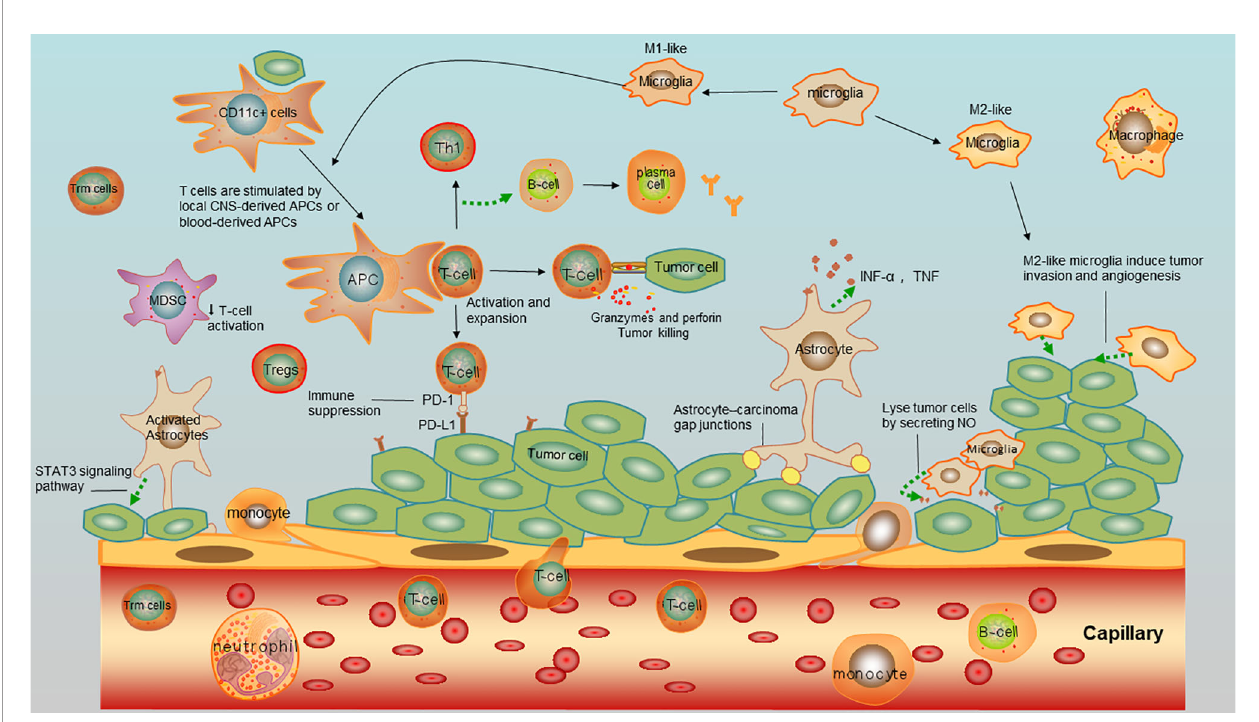
FIGURE 3 | Immnue microenvirment of brain metastases of NSCLC. Tumor cells interact with tumor-in fi ltrating lymphocytes (TILS), antigen-presenting cells (APCs), astrocytes, microglia, myeloid derived suppressor cells (MDSCs), and